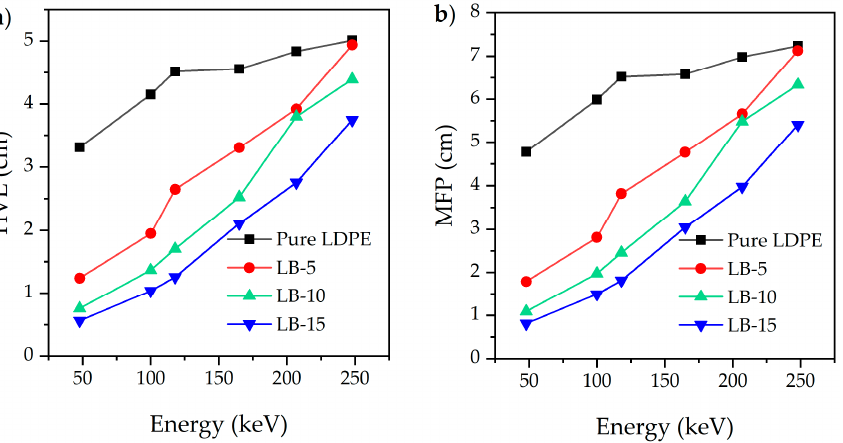
Figure 8. (a) HVL and (b) MFP values against energy for the composite samples prepared in this study.